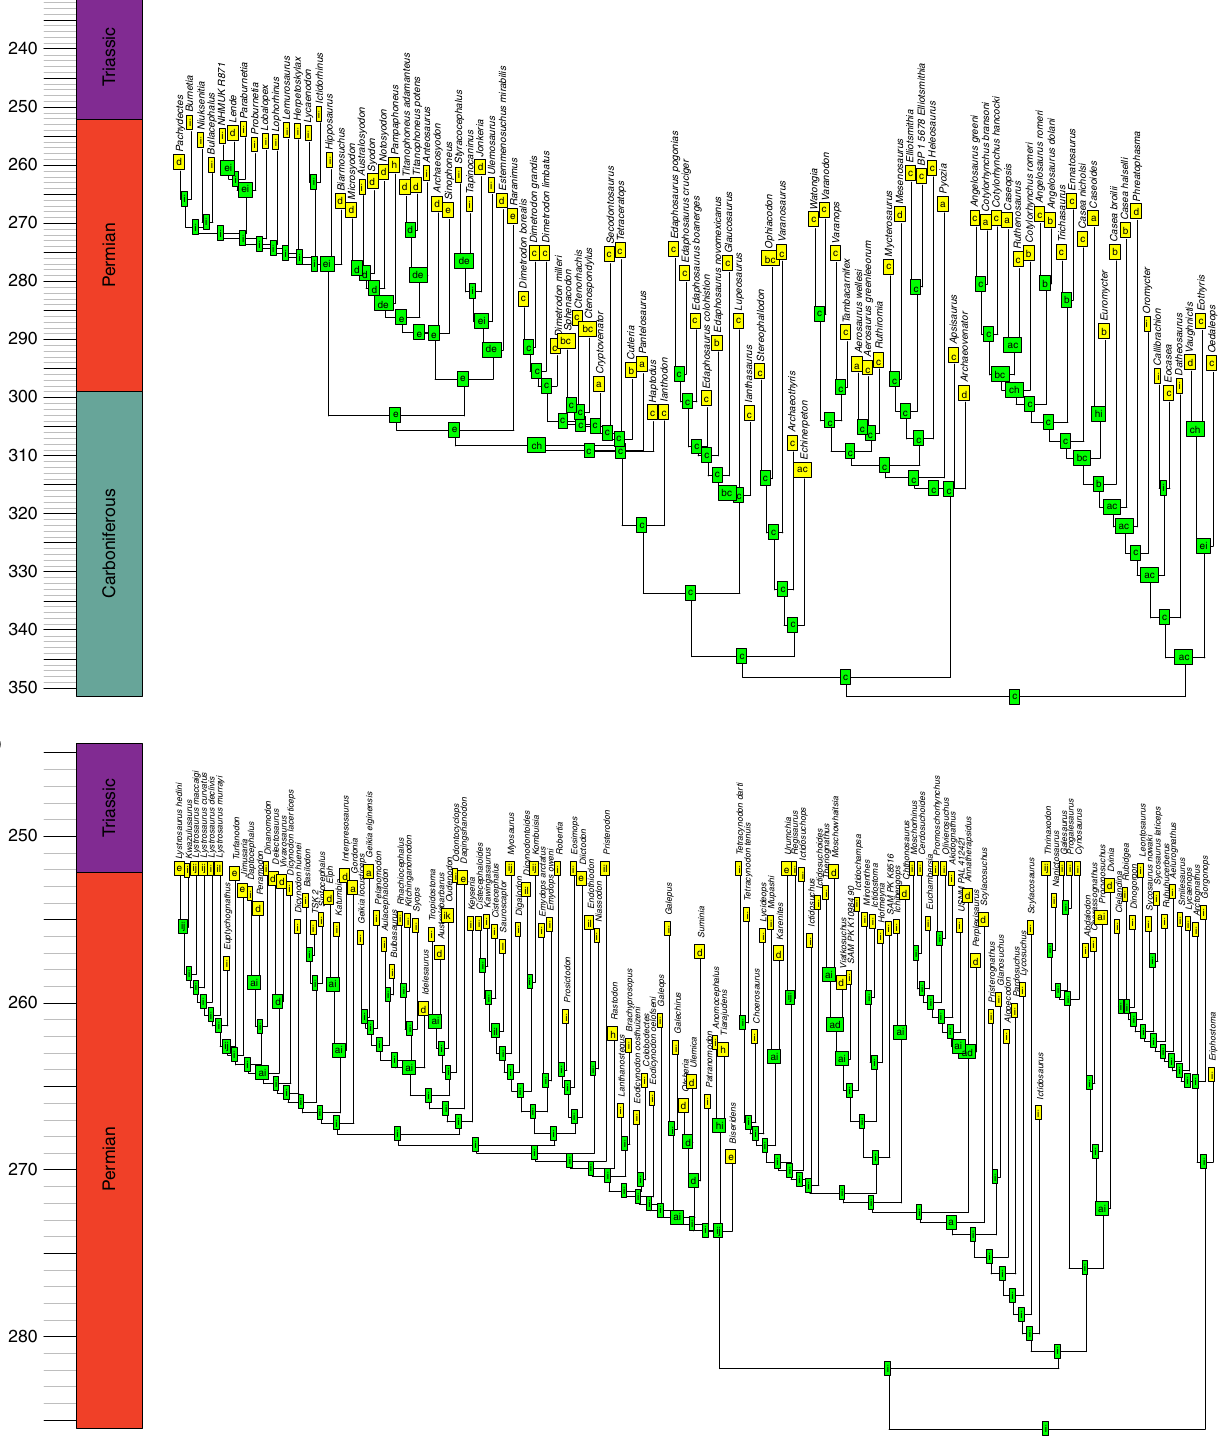
Fig. 7 Example of a reconstruction of ancestral geographic ranges of Synapsids. Tree was randomly selected from the 100 time calibrated trees. a Pelycosaurian-grade synapsids, Biarmosuchia and Dinocephalia. b Neotherapsida. Node labels represent the geographic range of that node with the highest probability, deduced by BioGeoBEARS. a = Western Europe; b = Western North America; c = Eastern North America; d = Eastern Europe; e = East Asia; f = Northern South America; g = Northern Africa; h = Southern South America; i = Southern Africa; j = Antarctica; k =